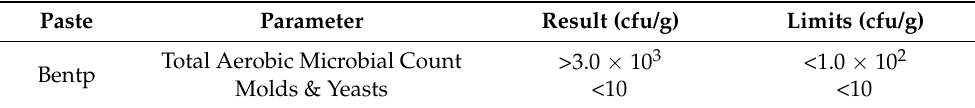
Table 5. Initial microbial load test according to the European Pharmacopoeia method.